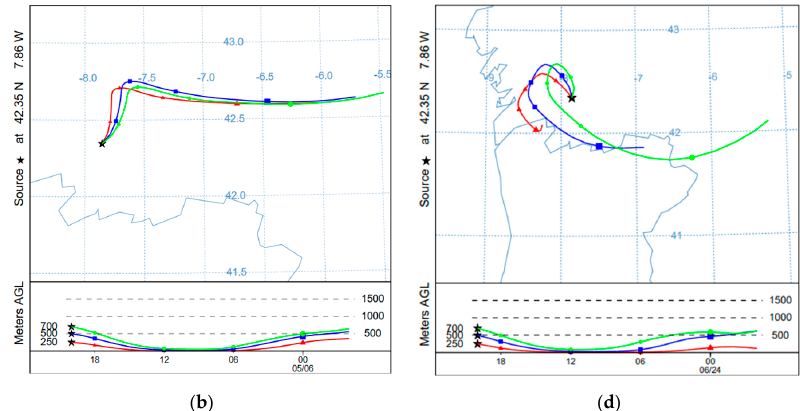
Figure 4. Sampling location area, green zones indicate the Betula and Olive groves use Spanish Forest Species Inventory for Betula and CORINE land cover for Olea. Maps showing 24-h HYSPLIT backward trajectories at a final height of 250, 500 and 700 m agl. at considered episodes: ( a ) 17 April 2017; ( b ) 6 May 2018; ( c ) 21 May 2017; ( d ) 24 June 2018.